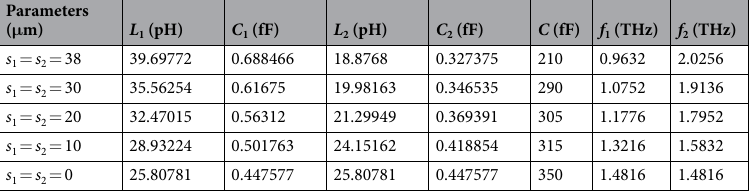
Table 1. Circuit parameter of equivalent transmission